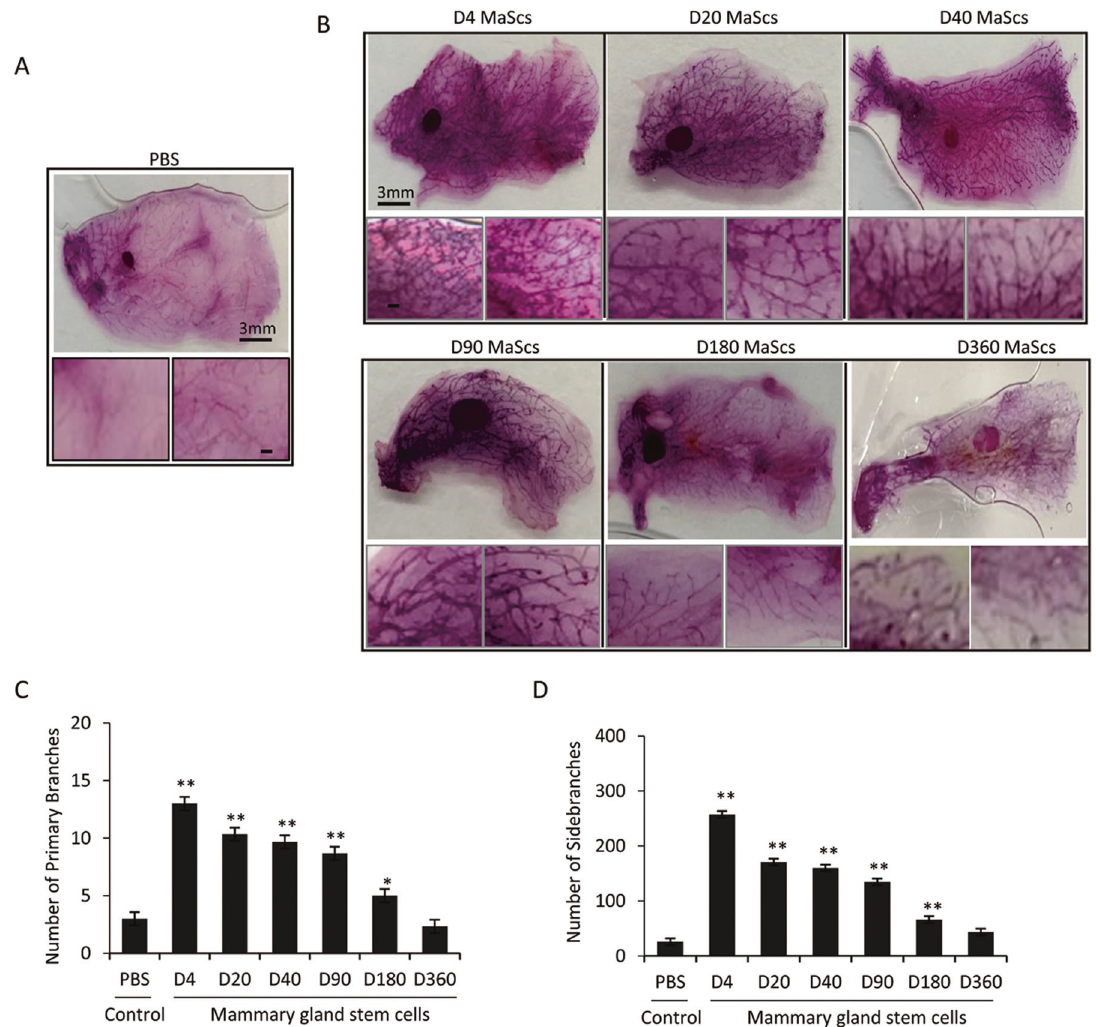
Fig. 2 Mammary gland regeneration in vivo after mammary stem cell transplantation. A , B Whole-mount staining of the mammary branching tree structures regenerated from the mammary stem cells isolated from mice at days 4, 20, 40, 60, 180, and 360 after birth, respectively. Same volume of PBS was used for injection as a negative control ( A ). Total amount of 500 MaSCs at each time point was transplanted into the epithelium-free mammary fat pad between the inguinal lymph node and the midline of 3-week-old female mice ( B ). C Quantitative analysis of the primary branches extending from the lymph node to end buds. D Quantitative analysis of the side-branches extending from the primary branches to end buds. Data are presented as the mean ± SEM ( n = 3). * p < 0.05, ** p <